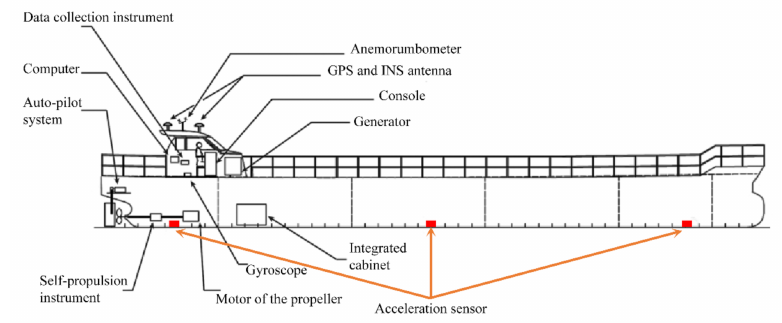
Figure 2. General arrangement of the relevant equipment on the large-scale ship